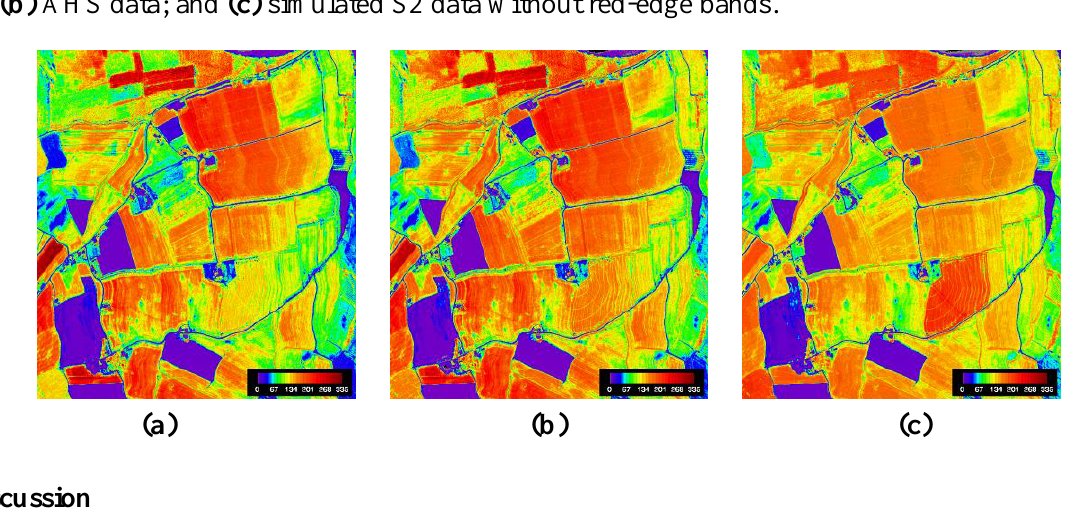
Figure 6. Canopy chlorophyll (Ch*LAI) maps, derived from: (a) simulated S2 data; (b) AHS data; and (c) simulated S2 data without red-edge